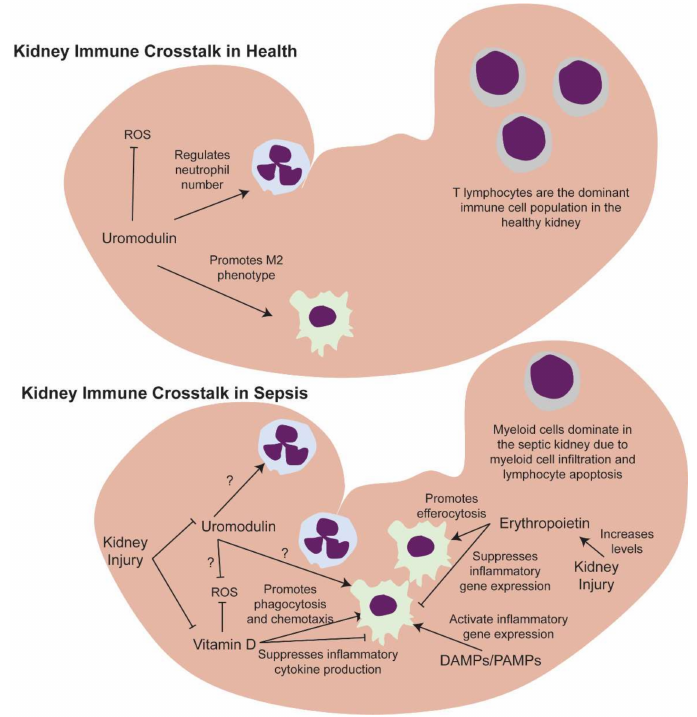
Figure 4. Kidney immune crosstalk in health and sepsis. Uromodulin’s immunomodulatory and anti- oxidative stress roles are well established in the healthy kidney, but it is unknown if these extend to sepsis. Vitamin D is known to promote phagocytosis and chemotaxis while suppressing inflammatory cytokine production. It can also mitigate renal oxidative stress. Erythropoeitin promotes efferocytosis and suppresses inflammatory gene expression. Damage- and pathogen-associated molecular patterns (DAMPs/PAMPs) increase in sepsis due to pathogen infiltration and cell damage. Kidney injury can modulate the levels of kidney-derived molecules. Erythropoietin increases with kidney injury while sufficient levels of kidney injury can deplete both uromodulin and vitamin